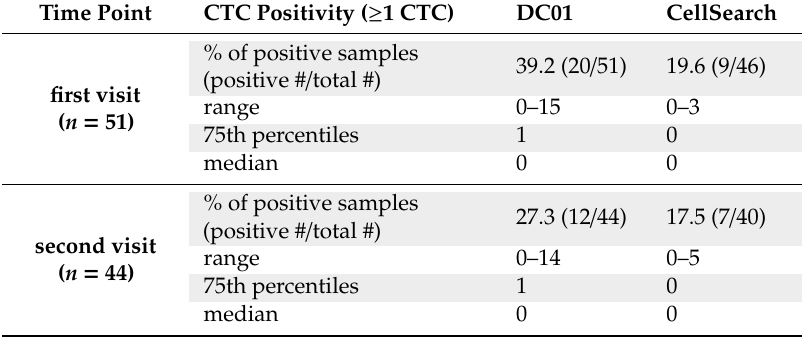
Table 2. CTC (circulating tumor cell) status detected by the two methods before and after